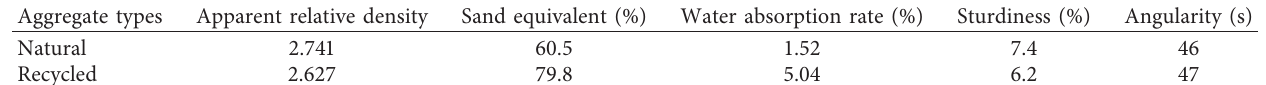
Table 2: Physical and mechanical performance of fine aggregates.